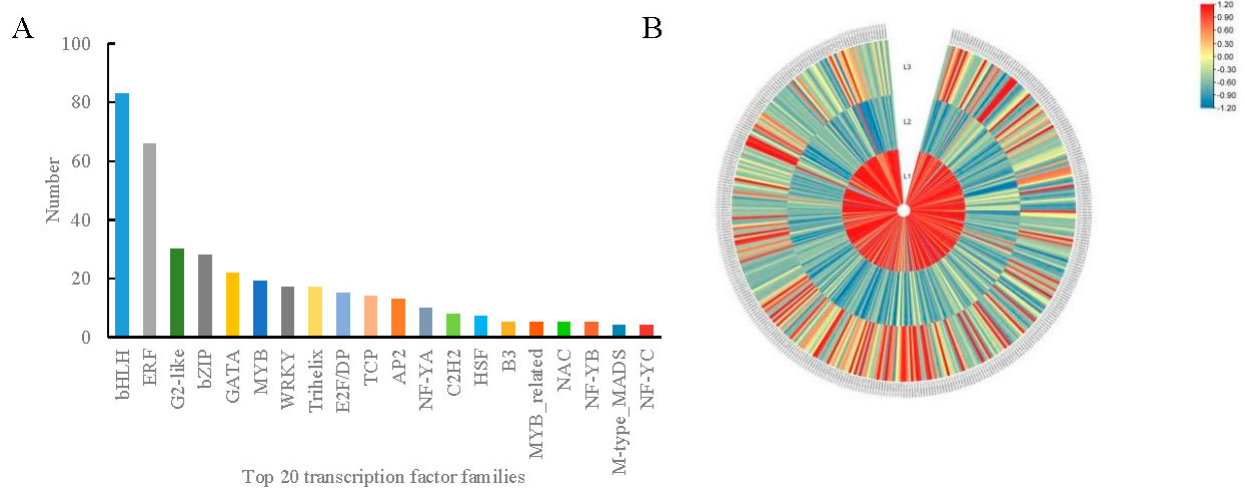
Figure 4. Characteristics and analysis of DEMs in walnut embryos at different developmental stages. ( A ) Heat map of DEMs based on the peak area. The color scale represents the calculated Z − score. The red blocks indicate upregulated metabolites; the blue blocks indicate downregulated metabolites. ( B ) Number of DEMs in different combinations. The blue bar denotes downregulated metabolites; the red bar denotes upregulated metabolites. ( C ) Venn diagram of DEMs in different combinations. L1 was 60 DAP, L2 was 90 DAP, and L3 was 120 DAP. (L2 − VS − L1, L3 − VS − L1, L3 − VS − L2; “a” was the experimental group; “b” was the control in “a − vs − b”).